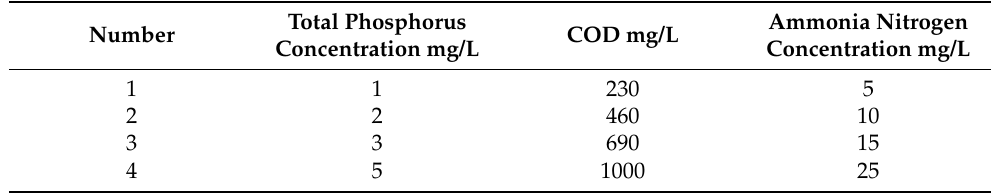
Table 2. Simulated sewage water quality index.